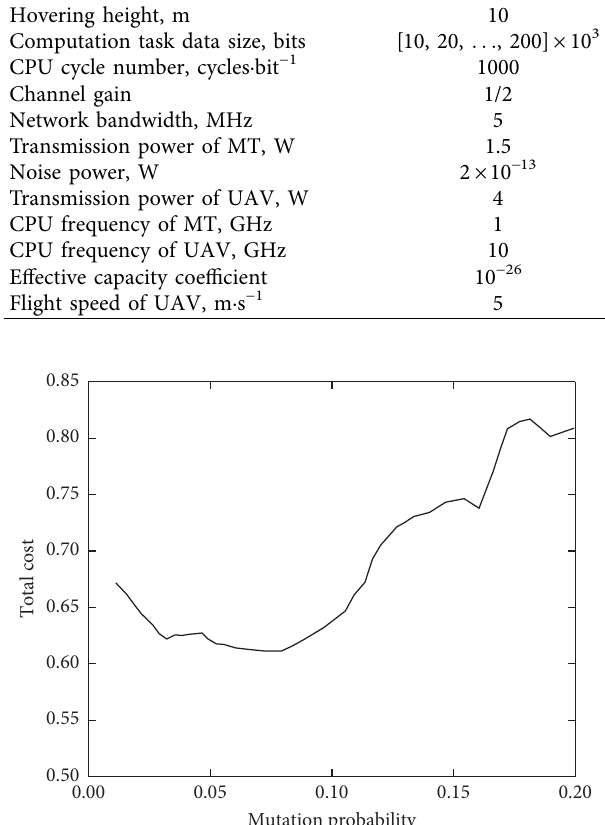
Figure 4: The effect of mutation probability on algorithm performance.